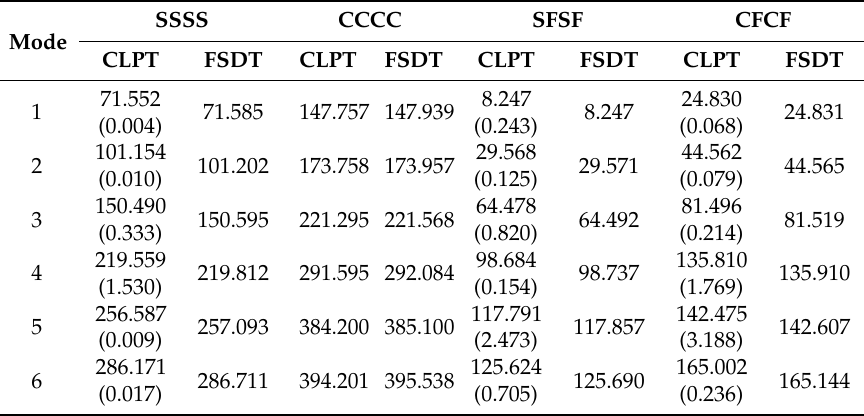
Table 2. Non-dimensional frequencies ω for α =